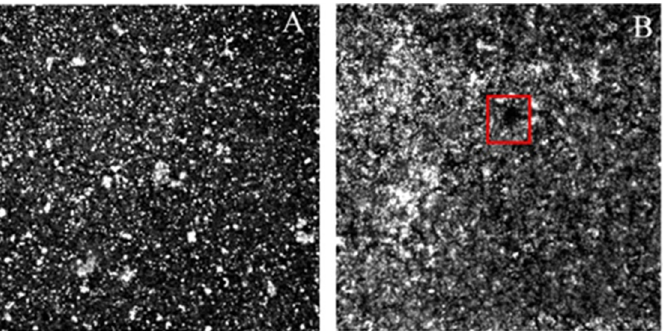
Figure 10. CLSM analysis (60 × magnification) of change in the biofilm composition between S. epider- midis RP62a ( A ) and RP62a- ∆ RNAIII ( B ) (red box shows perforation of biofilm described in results).